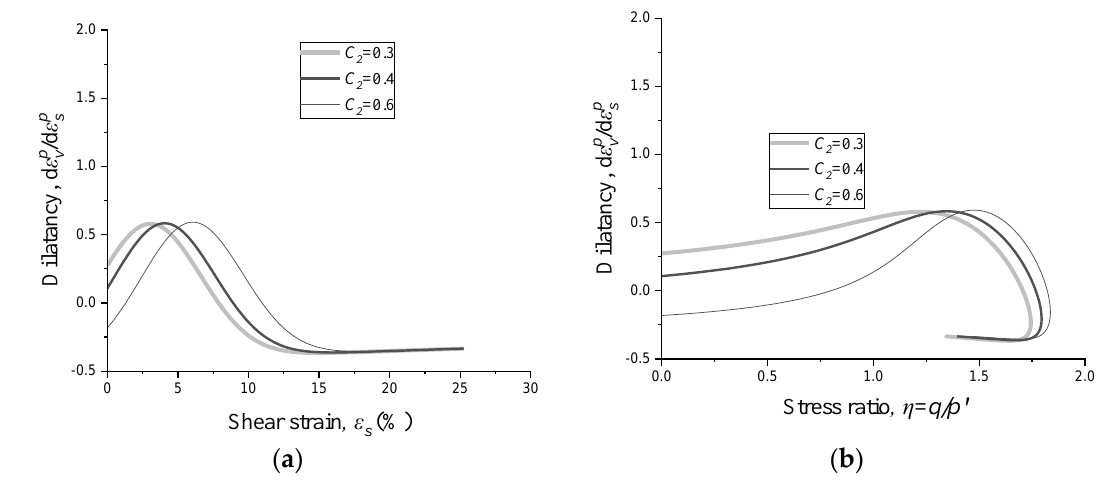
Figure 6. Effect of C 2 on dilatancy: ( a ) flow rule defined on the plane of dilatancy versus shear strain, and ( b ) flow rule defined on the stress − dilatancy plane.